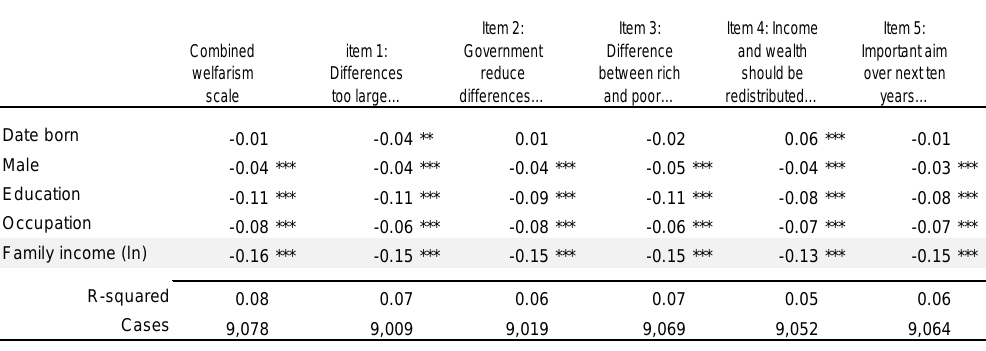
Figure A7. Individual level model predicting each of the five redistribution items separately. All five are available for three nations in the International Survey of Economic Attitudes Round 2 (Australia, Finland, The Netherlands).